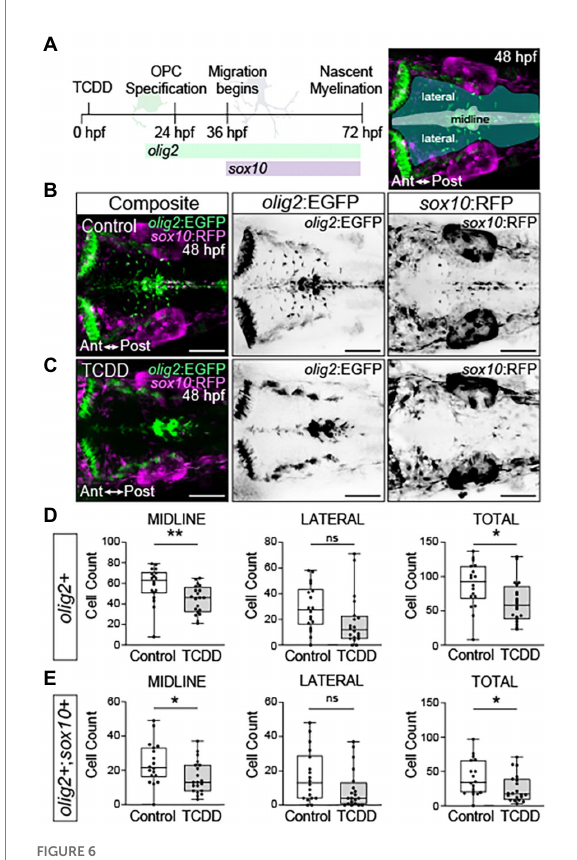
FIGURE 6 Embryonic TCDD exposure reduces oligodendrocyte numbers in the developing hindbrain. (A) Timeline of oligodendrocyte percursor cell (OPC) development and dorsal confocal images of the hindbrain at 48 hpf from transgenic zebrafish carrying fluorescent reporter genes for olig2 and sox10 [ Tg(olig2:EGFP; sox10:RFP) ]. Expression of olig2 marks oligodendrocyte precursors, oligodendrocytes, and motor neurons. Differentiated oligodendrocytes express sox10 , which also marks migrating neural crest cells and other neural crest derived lineages. olig2+ cells were quantified along the midline, laterally and in total for the developing hindbrain of control (B) and TCDD-exposed (C) embryos. (D,E) Co-expression of olig2 driven EGFP and sox10 driven RFP was used to identify and quantify differentiated oligodendrocytes in the hindbrain. Cells were quantified along the midline, where OPCs are located, and in lateral domains containing OPC derived motor neurons and differentiated oligodendrocytes. Statistical significance was determined by Welch’s t -test. * p < 0.05, ** p < 0.01. n = 18–20 fish/group across 3 replicates. Anterior (Ant) is left in all confocal micrographs. Scale bar = 100 μ m. Magnification =